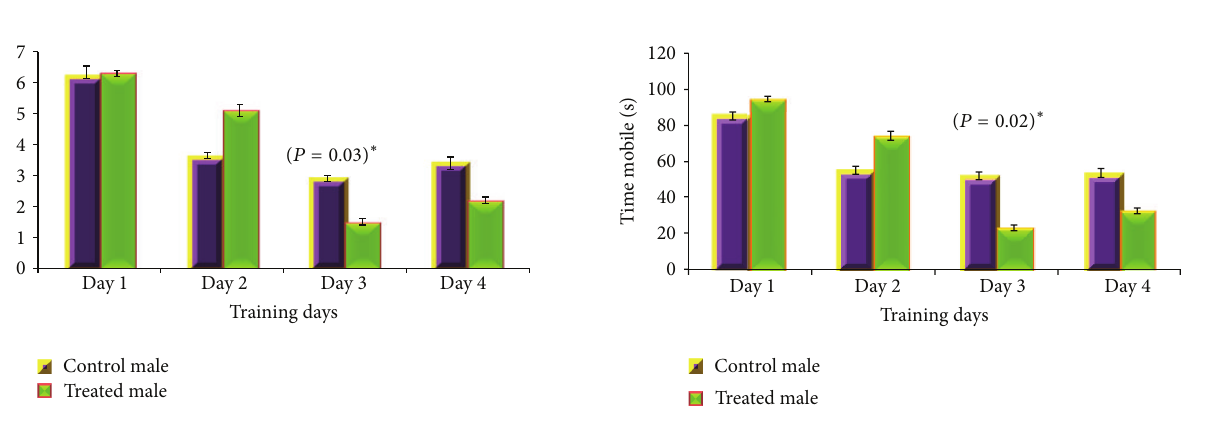
Figure 3: Comparison of time mobile (sec) by GABA B antagonist and saline treated male albino mouse during acquisition phase of Morris water maze test. Data is expressed as mean ± standard deviation. 𝑃 value indicates the result of 2-sample 𝑡 -test for the specific training day.